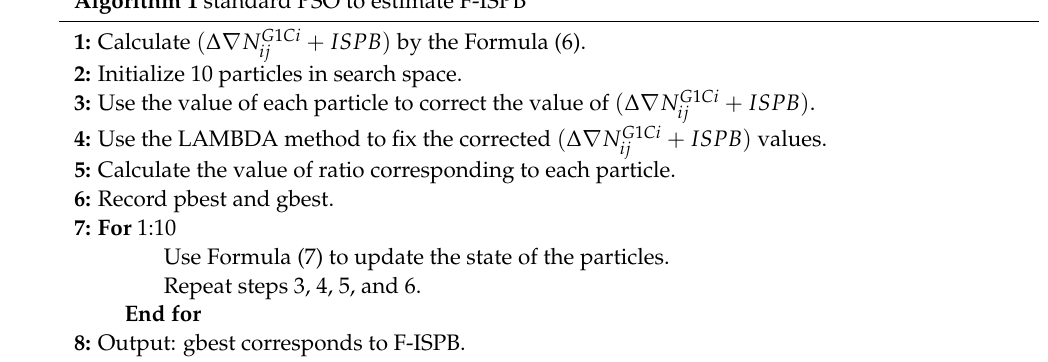
Algorithm 1 standard PSO to estimate